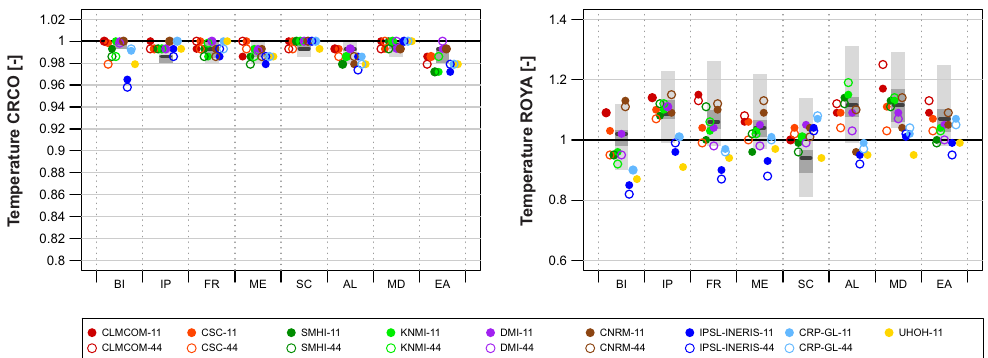
Figure 13. Model performance with respect to the mean annual cycle of temperature over each subdomain as expressed by the climatological rank correlation (CRCO, left panel) and the ratio of yearly amplitudes (ROYA, right panel). The gray bars denote the CRCO and ROYA ranges of the ENS-22 ensemble: entire range in light gray, interquartile range (corresponding to eight models) in dark gray and median as solid